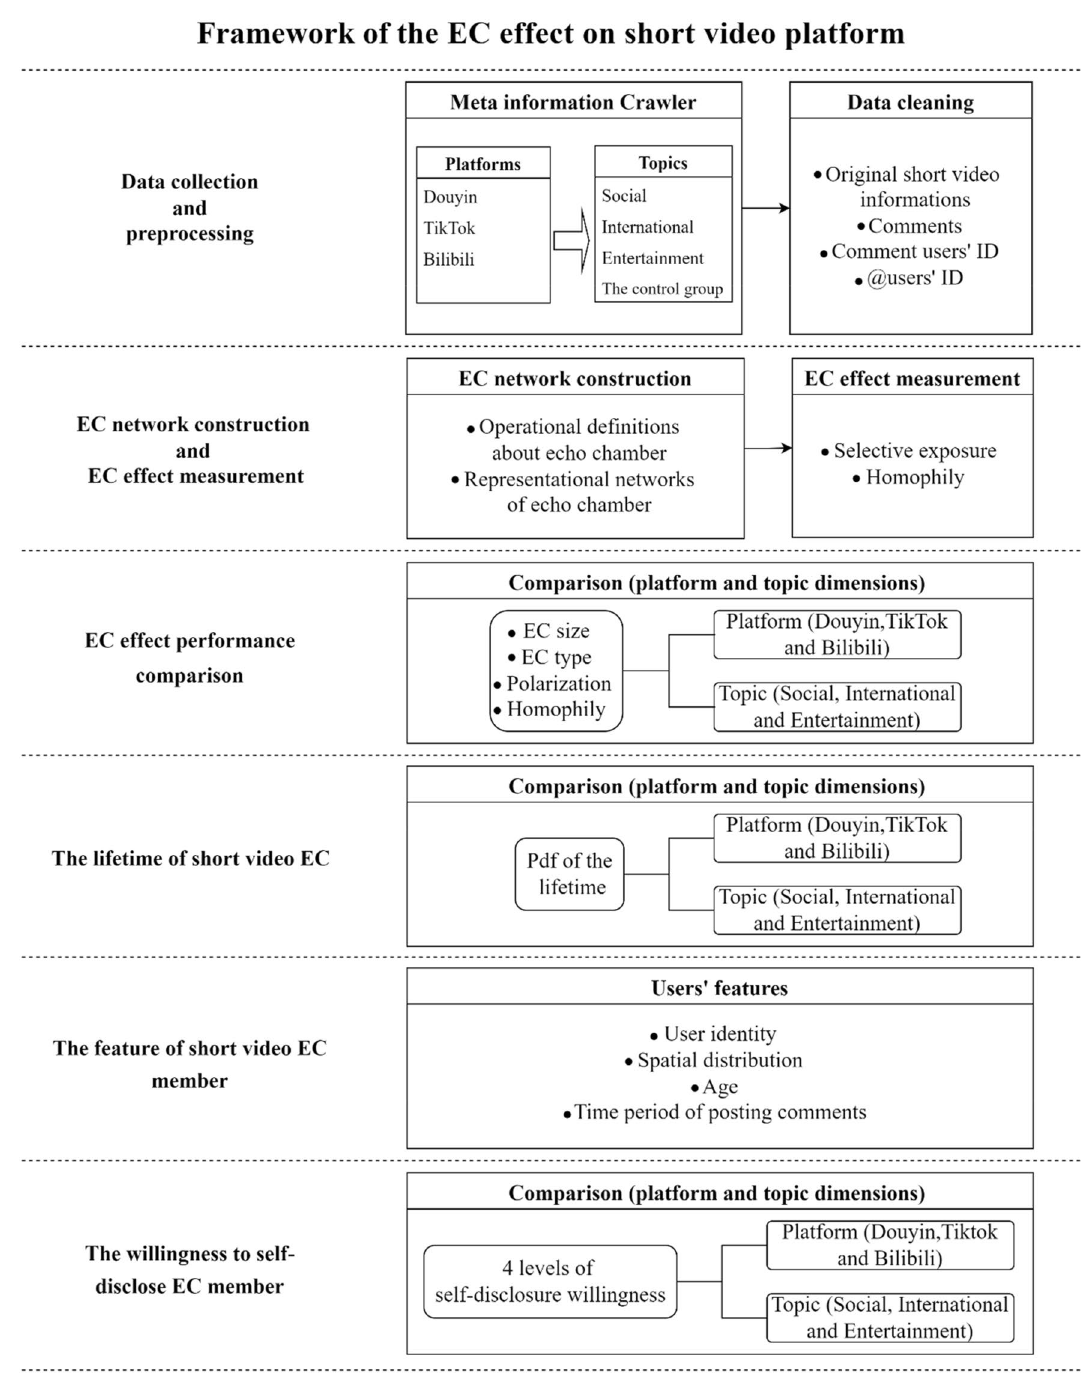
Figure 1. Framework of the methodology. The methodology in this work consists of six steps: (1) data collection and preprocessing, (2) EC network construction and EC effect measurement, (3) EC effect performance comparison, (4) the lifetime of short video EC, (5) the feature of short video EC member, and (6) the willingness to self-disclose of short video EC